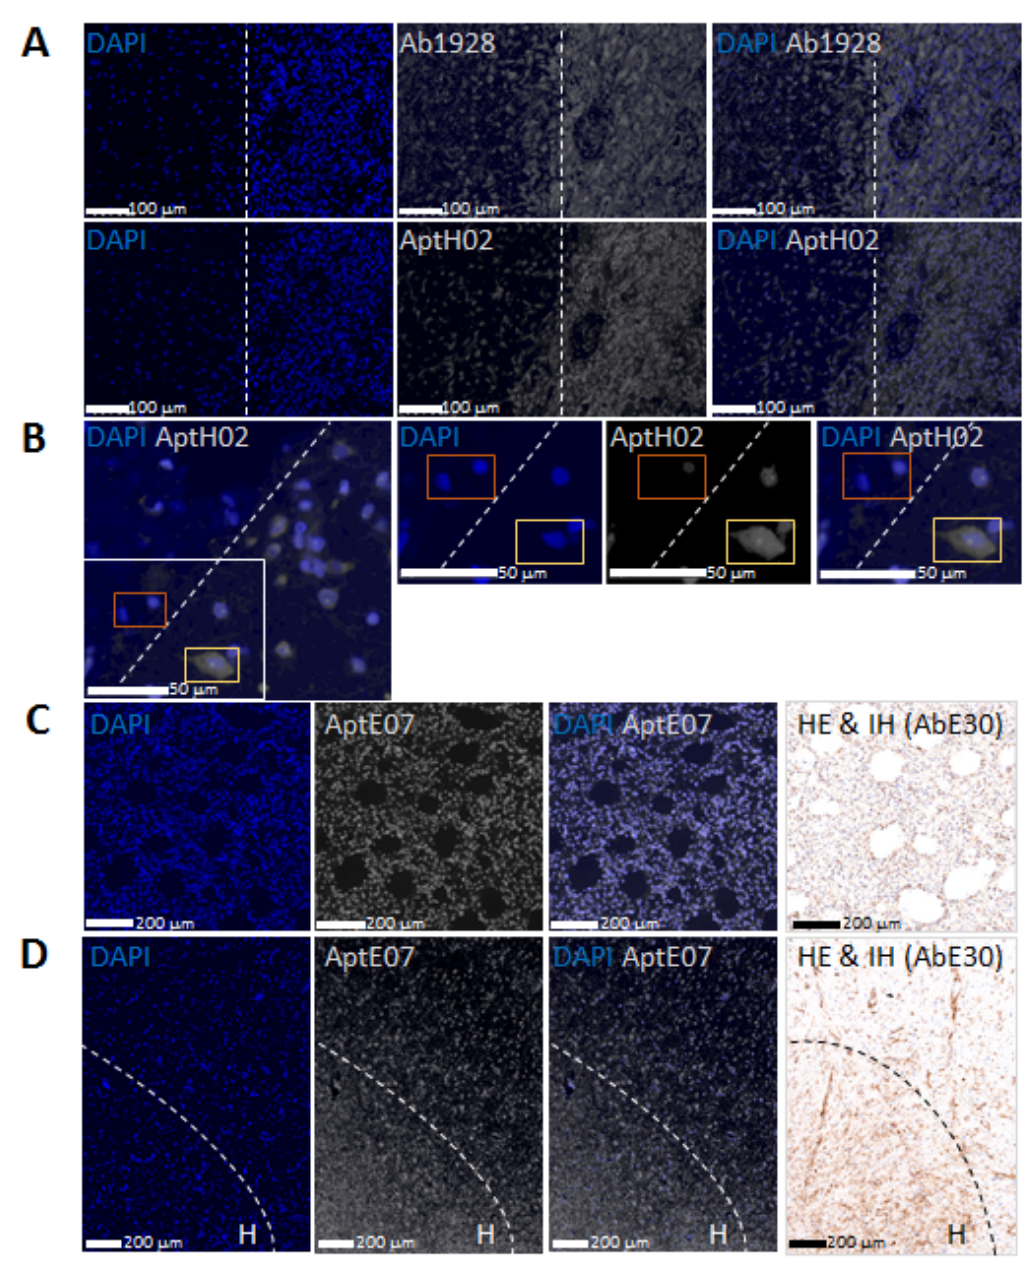
Figure 4. Imaging of intra- tumoral heterogeneity with aptamers targeting integrin α5 and EGFR. ( A ) Comparison of IHF and AHF for the detection of integrin α5. Equally scaled images taken with a Nanozoomer S60 slide scanner of two adjacent sections of the same tumor allowed us to perform a direct comparison between the fluorescence patterns of cells stained using IHF with antibody 1928 (Ab1928) and an Alexa647-conjugated secondary antibody and using AHF with Cyanine5-conjugated aptamer H02 (AptH02). Detection of integrin α 5 is represented in white. DAPI staining is shown in blue. The dotted line delimits two areas with a small and a large number of cells on the left and right sides of the images, respectively. Another representation showing the number of cells in the two areas is provided in Figure S3. Scale bar = 100 µm. The light microscopy result of an adjacent section is shown in Figure S2. ( B ) Detection of integrin α5 using AHF. This area further shows in more detail two zones delimited by a dotted line: no or very low integrin α5 on the left side and integrin- α5 positive cells on the right side. Magnified images are from the insert, either in single-channel mode or in merged- channel mode. Integrin α5 was detected with Cyanine5 -conju- gated aptamer H02 (AptH02), represented in white. DAPI staining is represented in blue. The or- ange and yellow squares show cells unlabeled and labeled with aptamer H02, respectively. Scale bar = 50 µm. ( C , D ) Comparison of AHF (first three images) and immunohistochemistry (image on